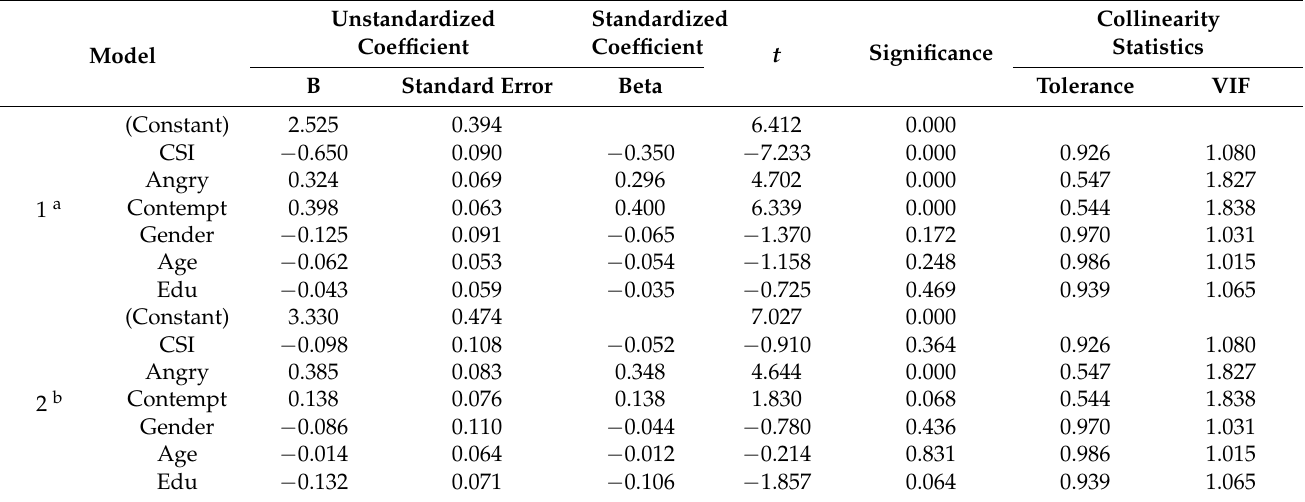
Table 4. The variance inflation